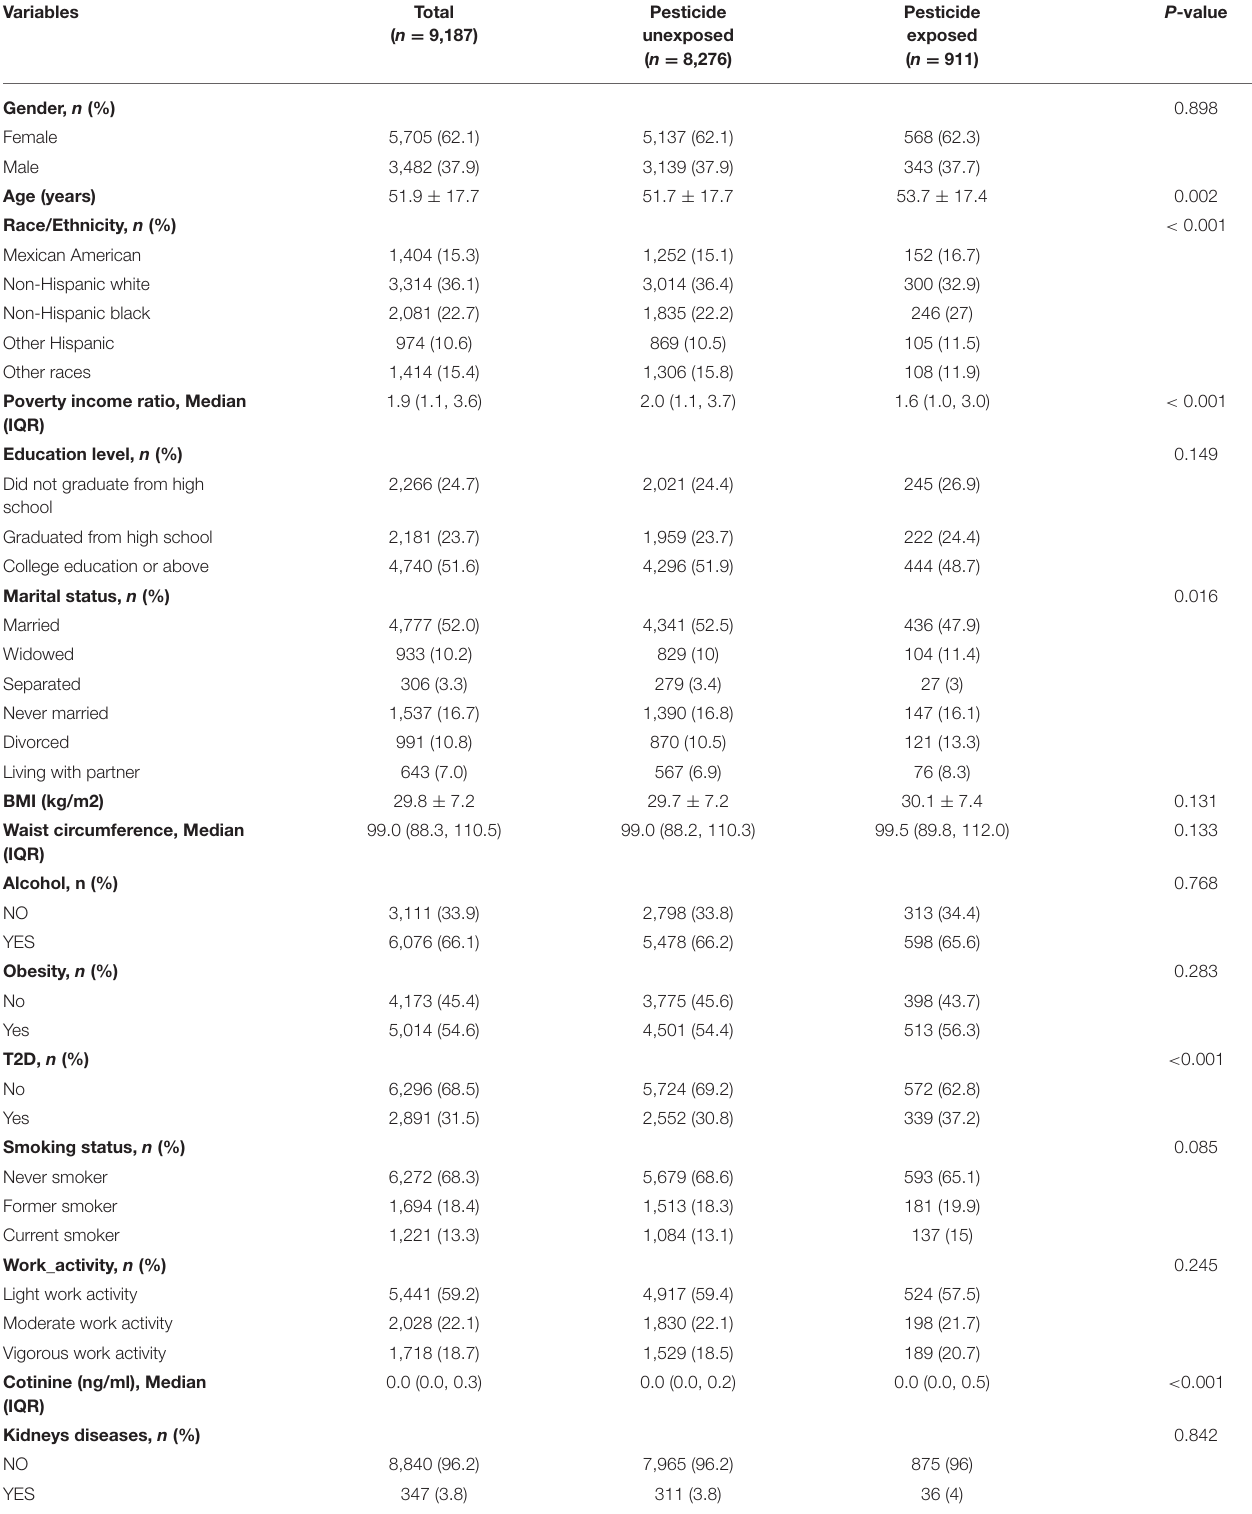
TABLE 1 | Baseline characteristics of the study